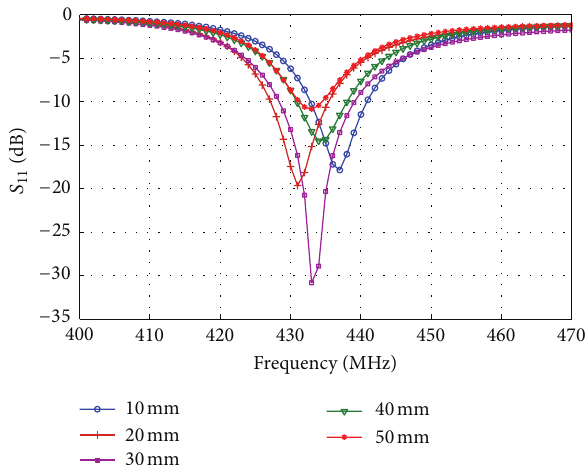
Figure 8: S 11 values for spiral antenna at a different water bolus